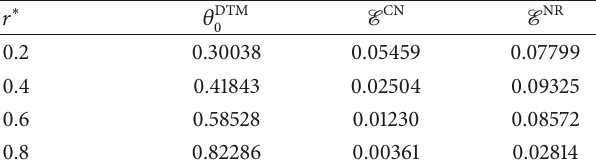
Table 8: Numerical solutions obtained for DTM and the maxi- mum error computed between the respective numerical solutions obtained, where E CN = max | CN sol − DTM sol | and E NR = max | CN NR sol − DTM sol | , and their respective temperatures at the tip of the fin, given as 𝜃 0 , for varied values of 𝑟 ∗ . 𝑟